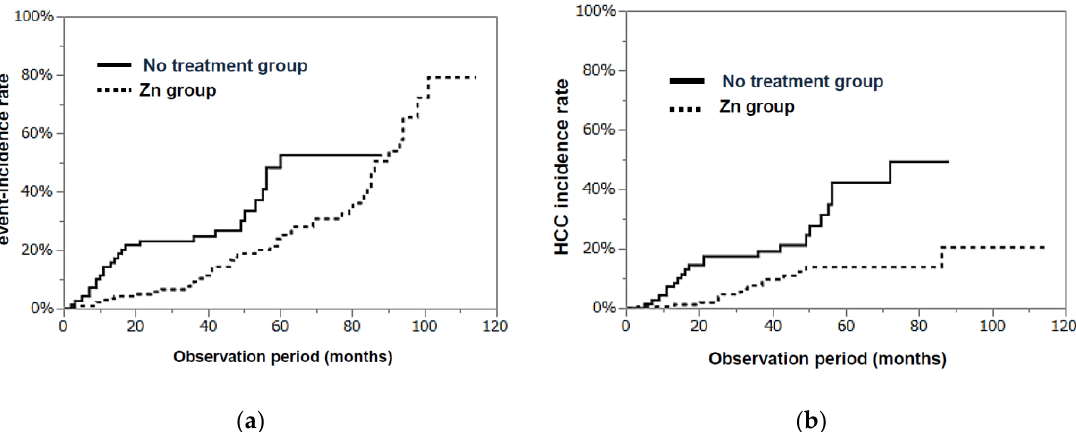
Figure 4. ( a ) The cumulative incidence rates of events (death, the development of HCC, and appearance of liver failure) in the Zn- and no Zn-treatment groups (log-rank test p = 0.0049). ( b ) The incidence rates of HCC in both groups (log-rank test, p = 0.0002).